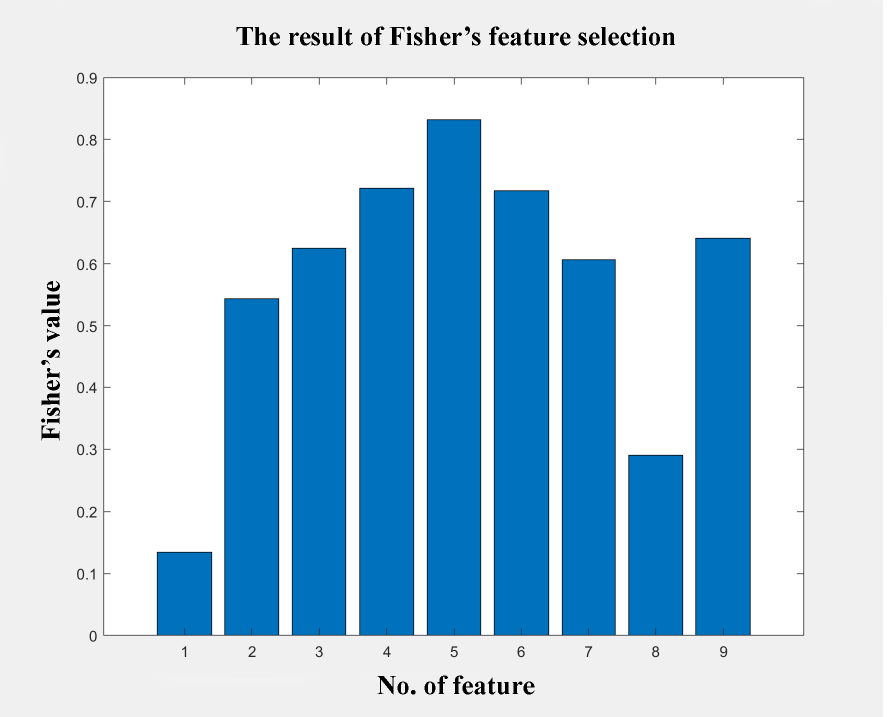
Figure 7. The result of features selection using Fisher’s